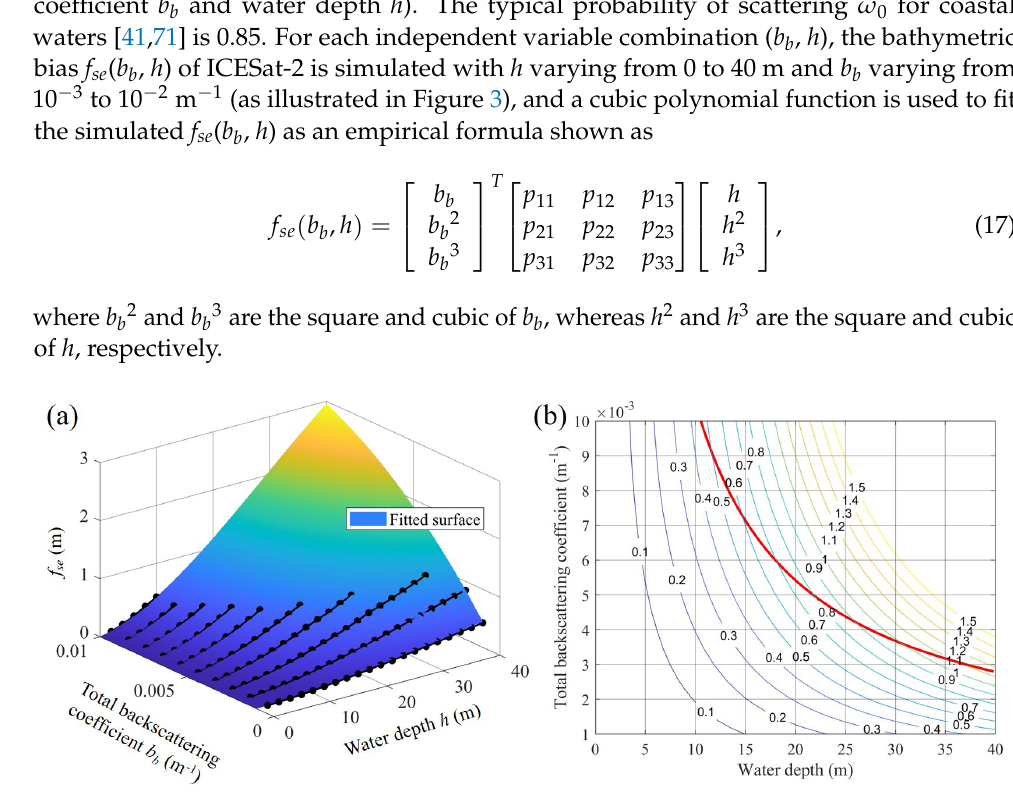
Figure 3. Bathymetric bias due to the forward scattering f se ( b b , h ) of ICESat-2 with total backscattering coefficients and different depths. ( a ) Black points correspond to the simulated results, which are used to fit the nine parameters in Equation (17). The fitted surface is then drawn by inputting the nine fitted parameters into Equation (17). ( b ) f se ( b b , h ) contours of the fitted surface in units of meters. The red curve represents the estimated maximum bathymetric depth of ICESat-2 and the upper right area is generally not measurable for ICESat-2.